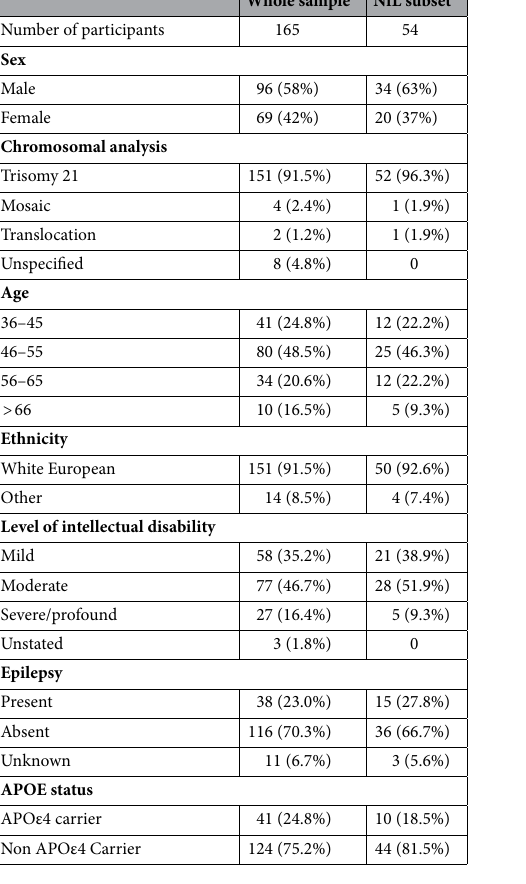
Table 1. Demographic